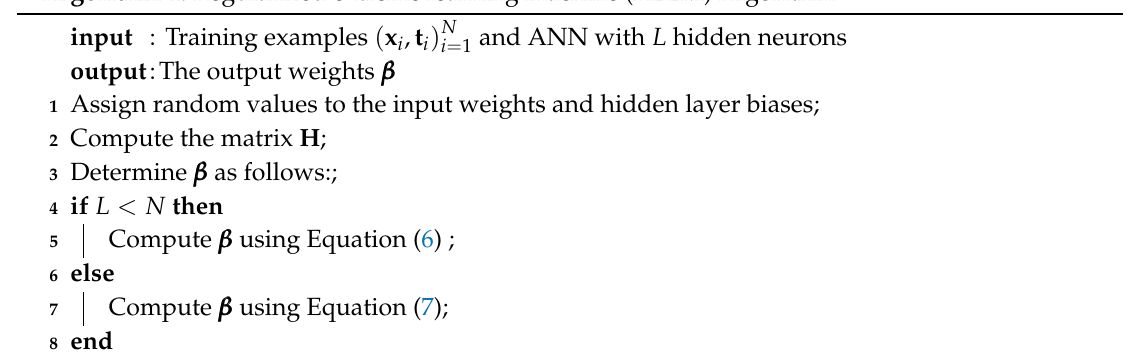
Algorithm 1: Regularized extreme learning machine (RELM)